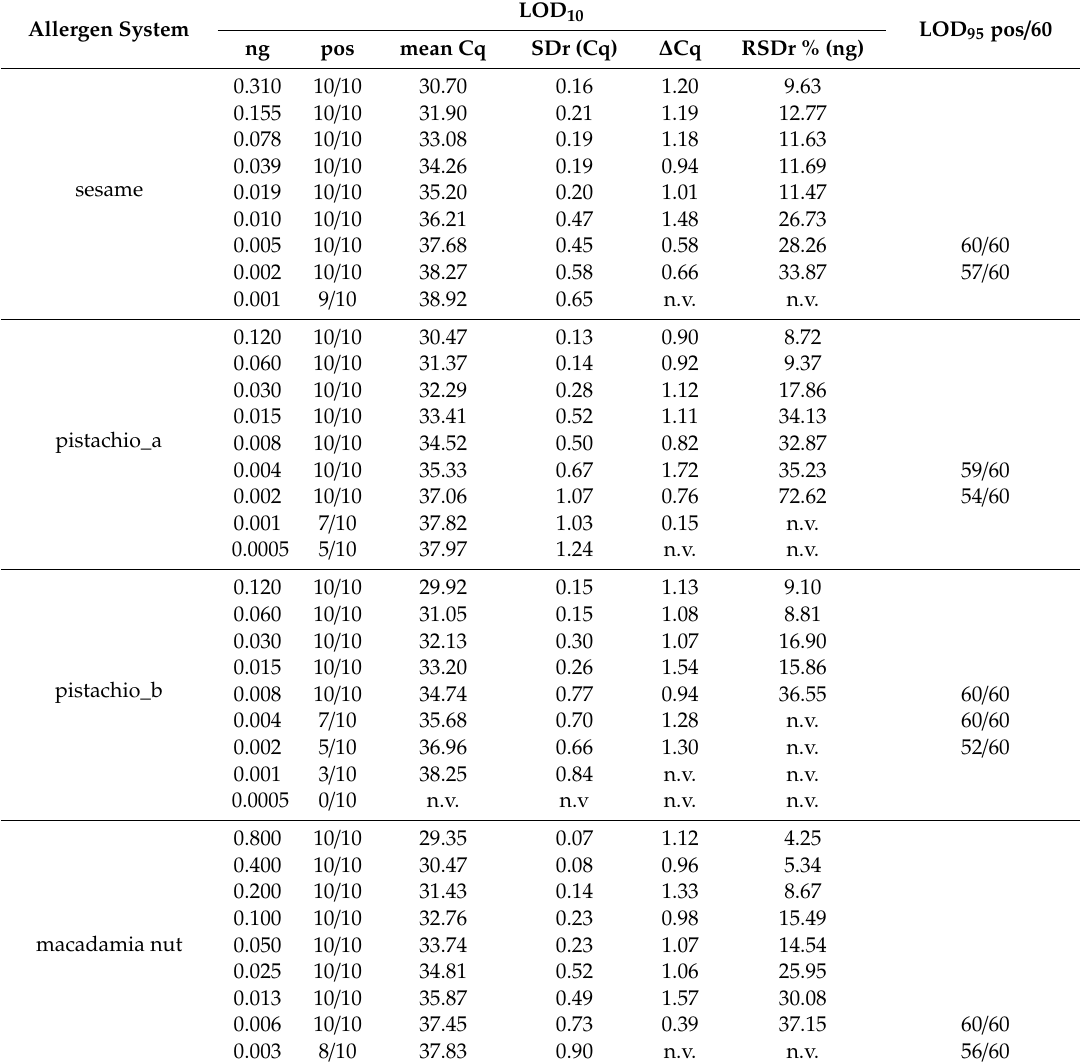
Table 4. Limit of detection (LOD) results for sesame, pistachio (a–b) and macadamia nut systems. Allergen